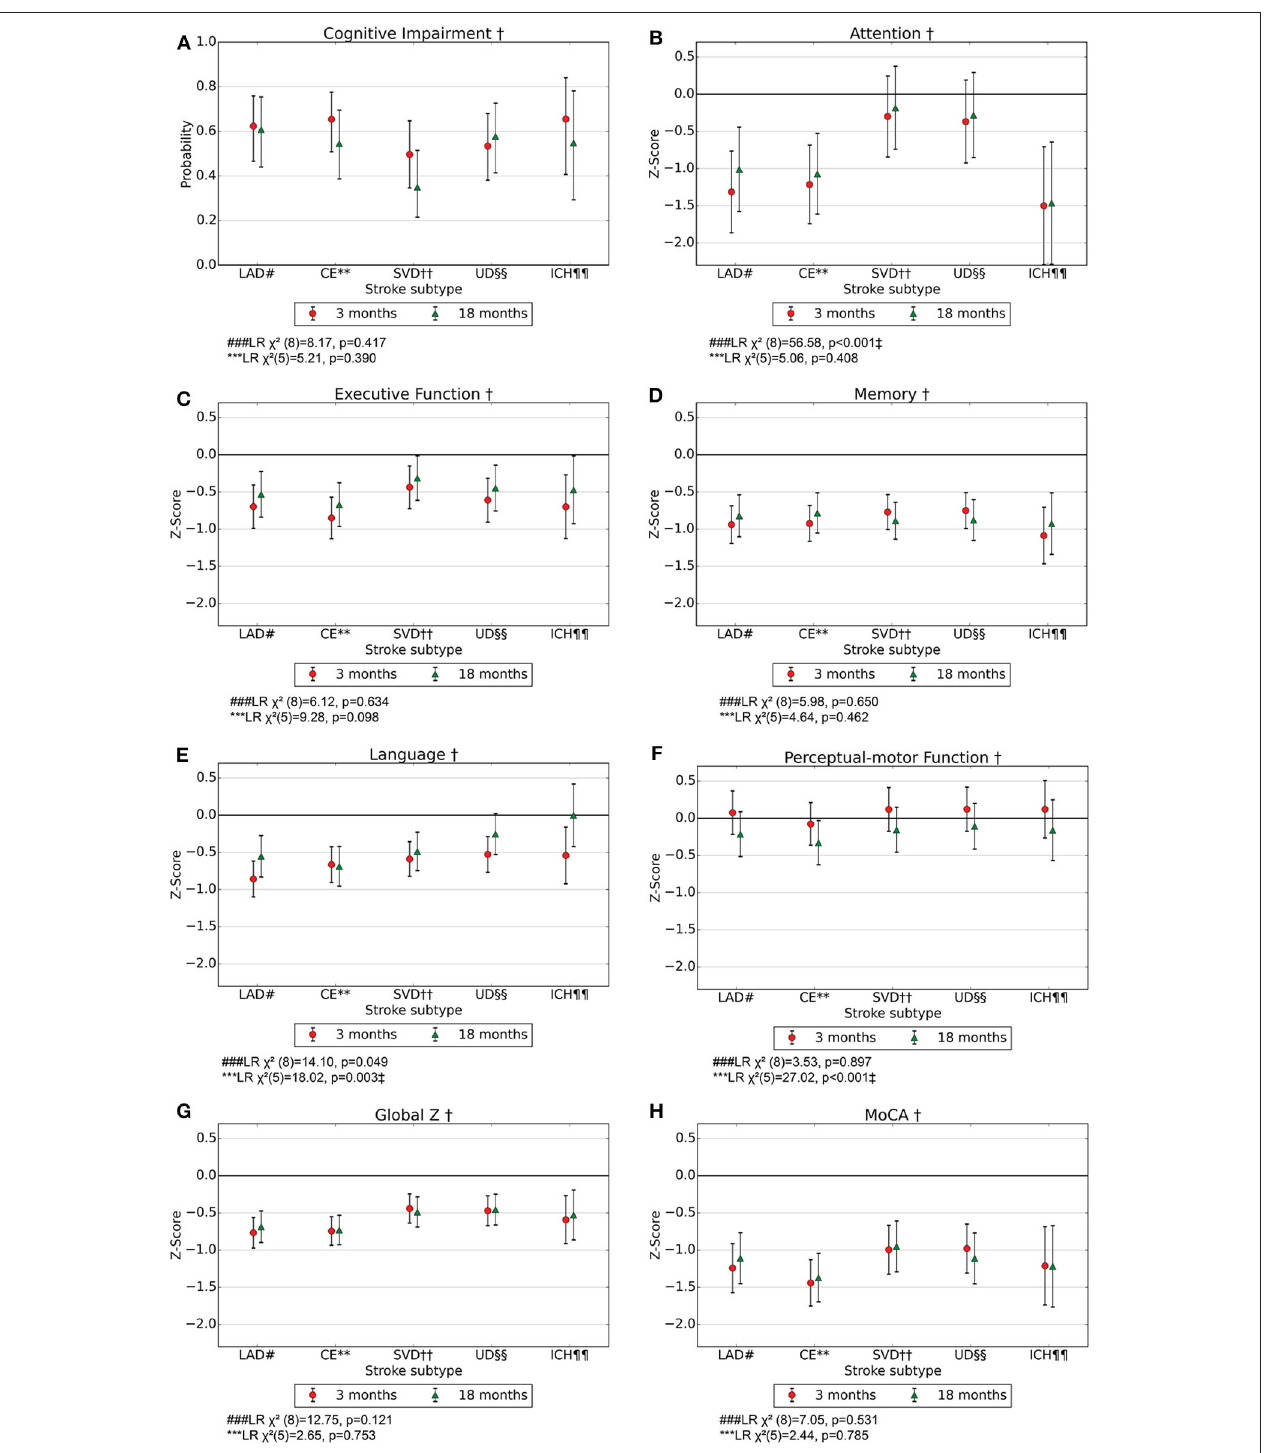
FIGURE 3 | (A–H) Probability for cognitive impairment according to DSM-5 criteria with 95% CI and mean z-score with 95% CI for the cognitive domains at 3- and 18-months post-stroke in model 2. MoCA, Montreal Cognitive Assessment. † Adjusted for age, education, and sex. # LAD, Large artery disease. **CE, Cardiac emboli. †† SVD, Small vessel disease. §§ UD, Undetermined and other determined strokes. ¶¶ ICH, Intracerebral hemorrhage. ### LR χ 2 (8), Likelihood Ratio test model 1 vs. model 2 with 8 degrees of freedom; hypothesis test of whether there is an effect of stroke subtype. ***LR χ 2 (5), Likelihood Ratio test model 2 vs. model 3 with 5 degrees of freedom; hypothesis test of whether there is an effect of time for at least one stroke subtype. ‡ p < 0.01.